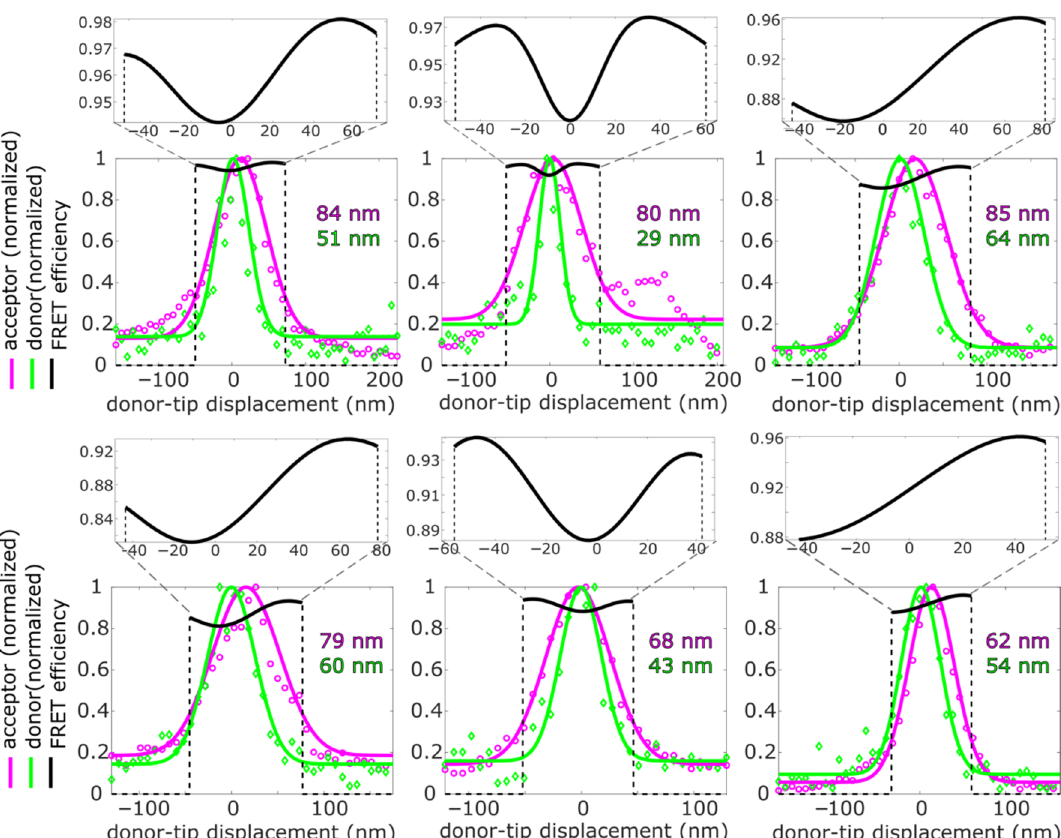
Figure 5: Line profiles of several FRET spots as a function of the antenna position taken along the y -scanning direction. Magenta represents the normalized signal from the acceptor channel, green from the donor channel and black corresponds to the FRET ef fi ciency. Top insets are expanded plots of the FRET ef fi ciency lines pro fi les. The zero position in the x -axis is de fi ned at the pixel where the donor signal is maximum. The numbers on the right of each pro fi le correspond to the respective FWHMs of donor and acceptor, obtained from Gaussian fi ttings to the experimental